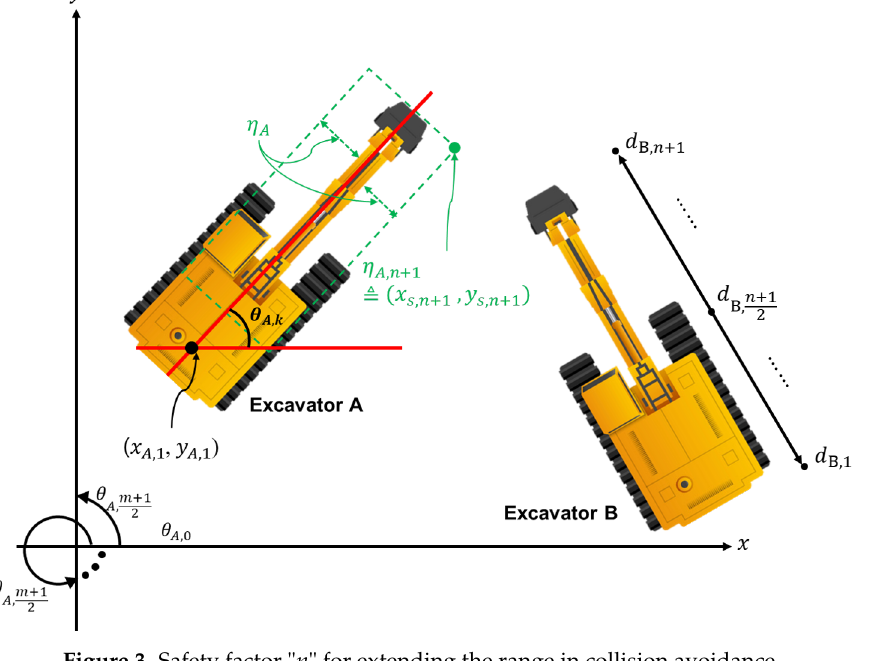
Figure 3. Safety factor " η " for extending the range in collision